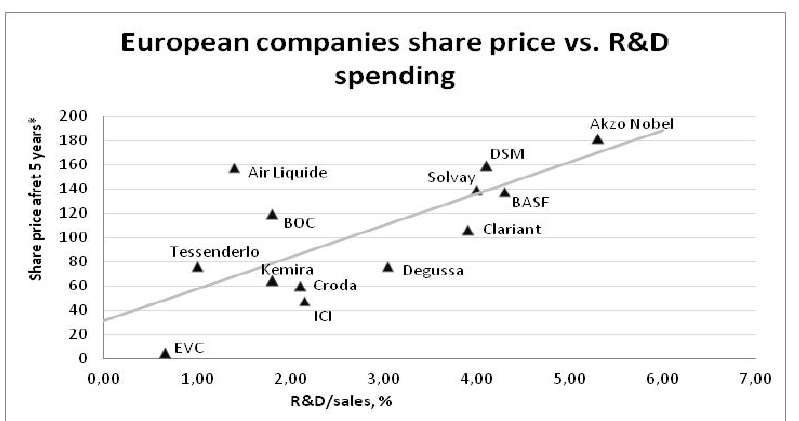
Fig. 1. Dependence between share prices and R&D spending in chemical companies (Morris,